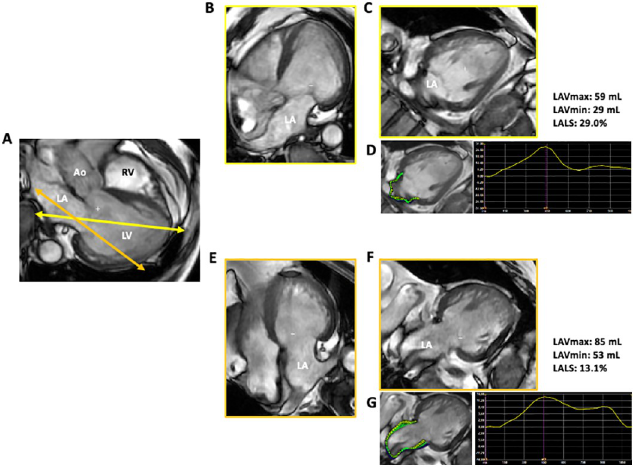
Fig 3. CMR feature tracking analysis of LA. A: A cut-plane optimized for the left ventricle (yellow arrows) and that optimized for the left atrium (orange arrows) were determined using apical long-axis SSFP images. These planes rotated to the same degree to generate apical four-chamber and two-chamber views aimed for the left ventricle (B and C) and those aimed for the left atrium (E and F). D: Feature tracking of the LA wall using LV-focused, two-chamber view and the corresponding LA strain curve. G: Feature tracking of the LA wall using LA-focused, two-chamber view and the corresponding LA strain curve. LAVmax, maximal LA volume; LAVmin, minimal LA volume; LALS, LA longitudinal